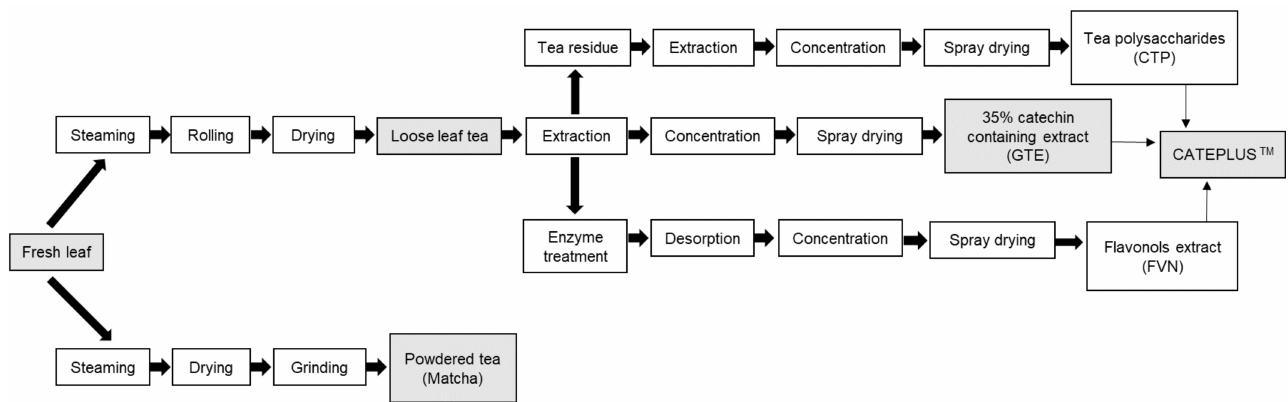
Figure 2. Scheme for each processing condition in green tea leaves (loose leaf tea and powdered tea) and its commercialized extracts (35% catechins containing green tea extracts, GTE formulated with polysaccharides and flavonols). GTE: 35% catechins containing